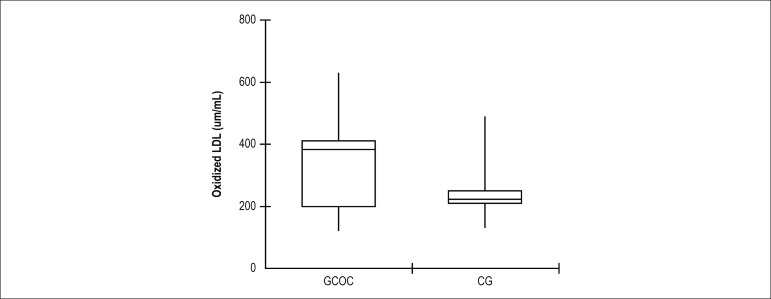
The boxplot shows a higher concentration of oxidized LDL in women using
combined oral contraceptives compared to those who did not use this
group of drugs (p < 0.01). In addition, it is noted that in the GCOC
the concentration of this oxidized lipoprotein is in the first quartile,
while the CG is in the third quartile. The comparison of the median
between groups was compared by bidirectional Mann-Whitney test.